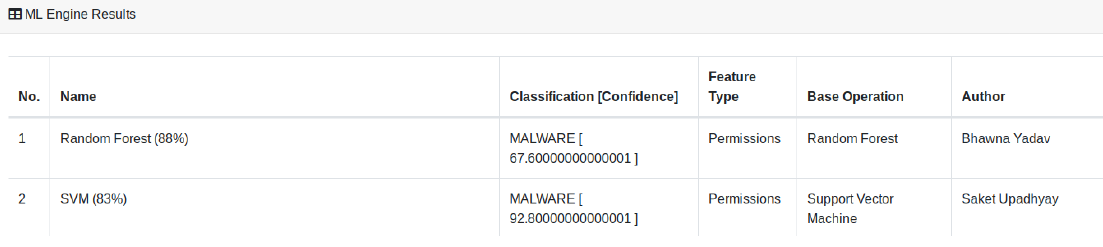
Figure 5. Output of Trained